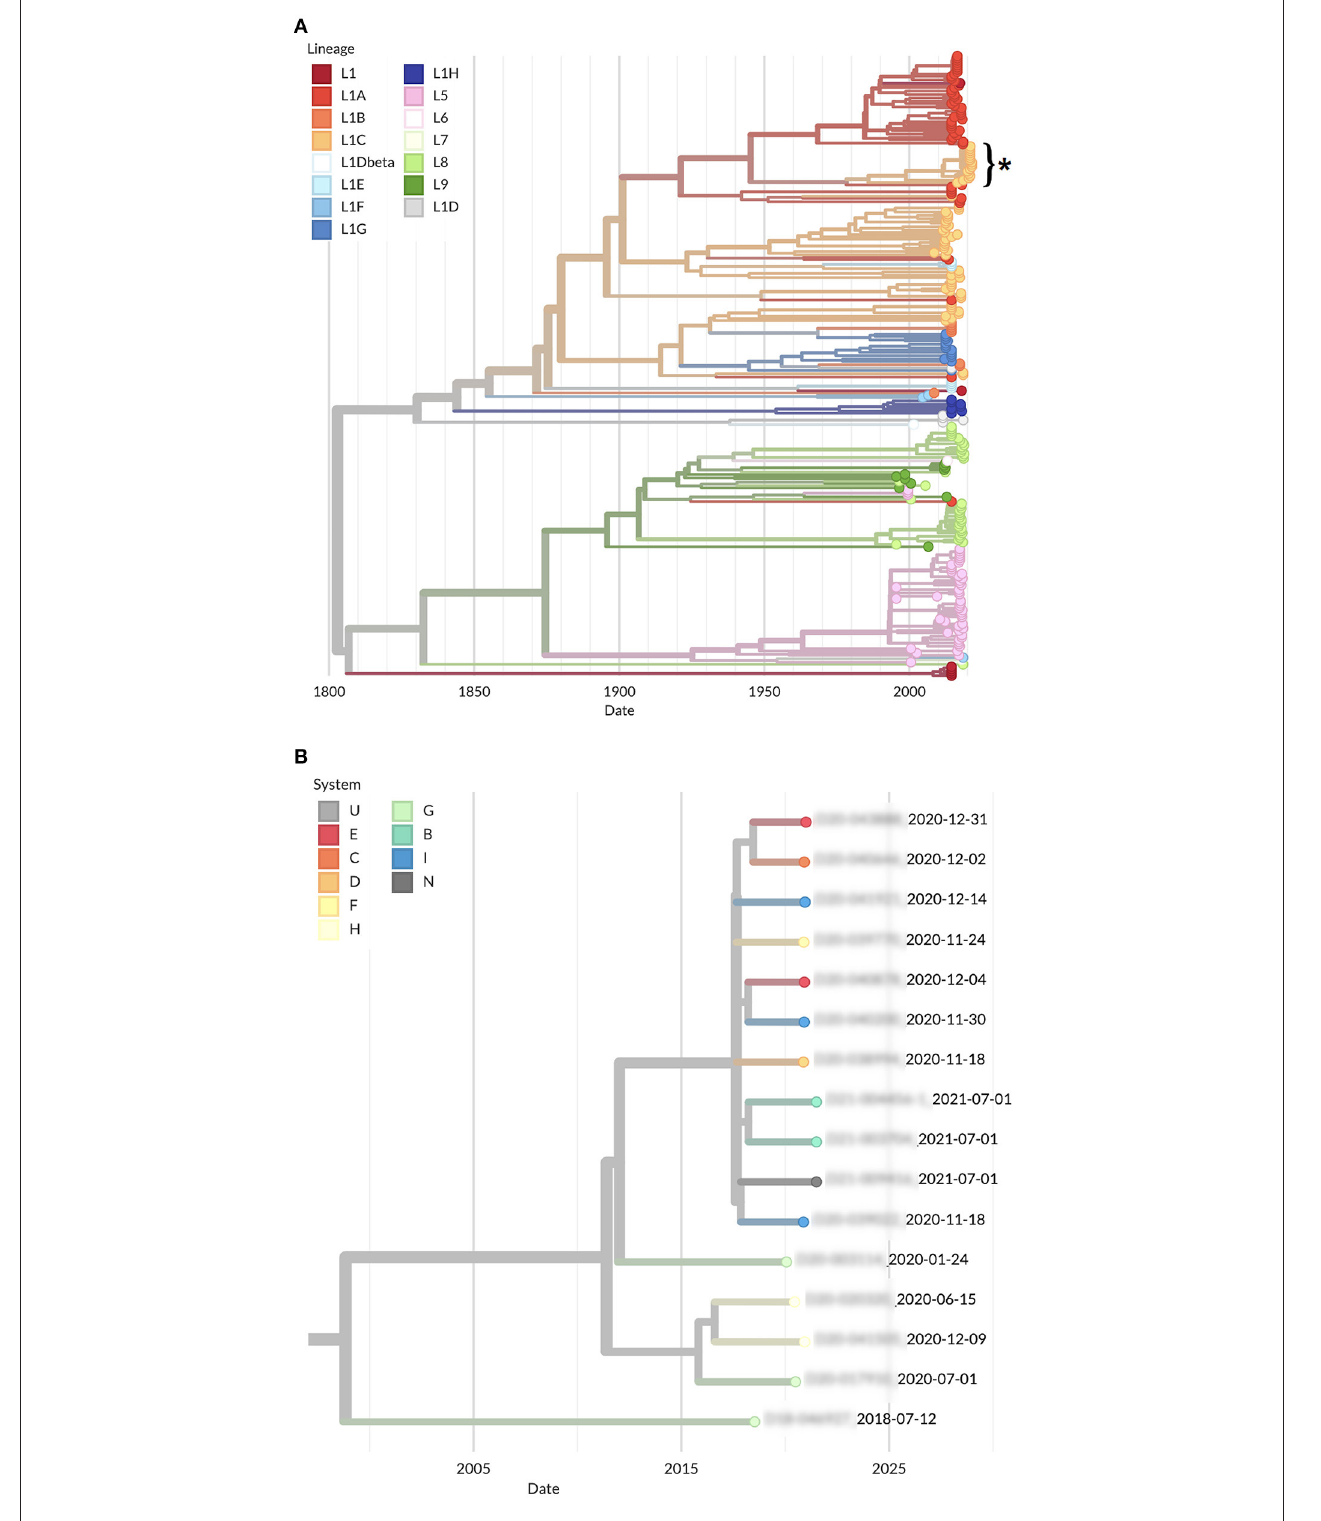
FIGURE 3 | Phylogenetic tree of PRRSV whole genome sequences (A) Publicly available at GenBank color coded by lineage (asterisk represents outbreak cases), and (B) Close up of the clade containing all sequences belonging to this outbreak color coded by production system.